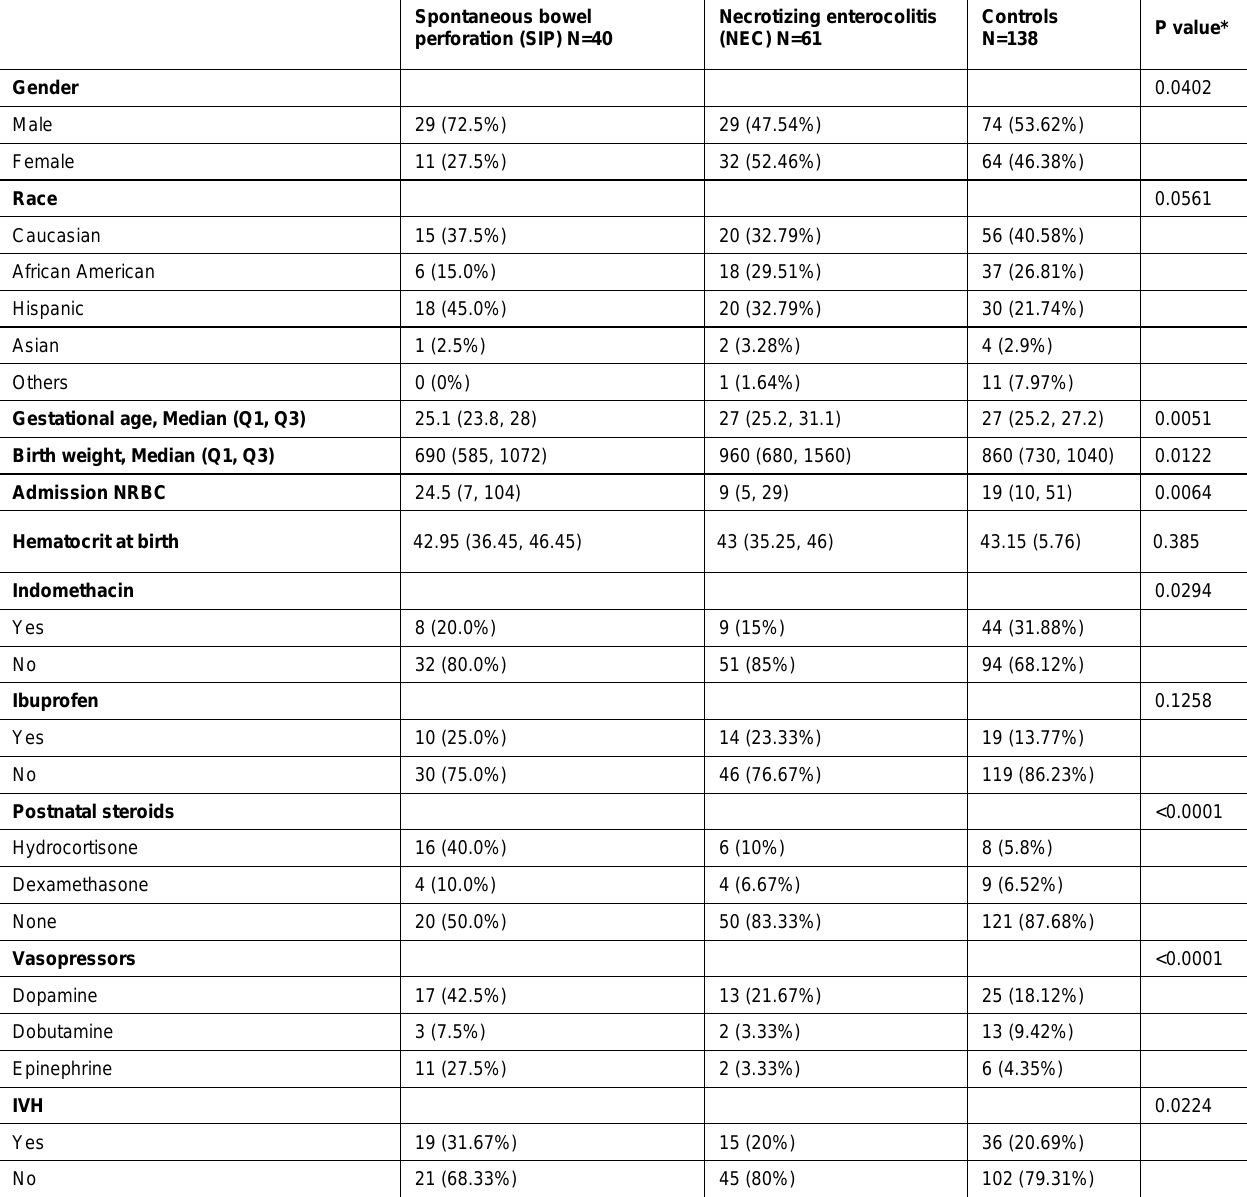
Table 1. Descriptive Statistics, n